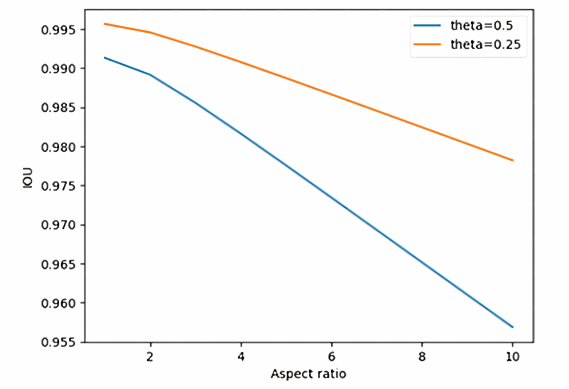
Figure 3. IOU loss under different aspect ratios.